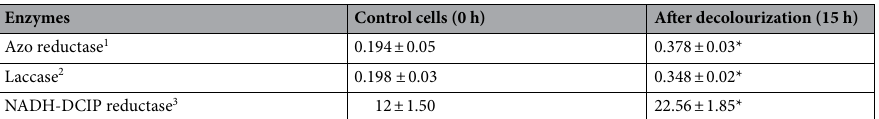
Table 2. Enzyme activity during decolourization of dye Procion Red—H3B by strain P. stutzeri SPM1. Values are mean of three experiments ± standard error of mean (SEM), significantly different from control cells at * P < 0.001 by one-way analysis of variance (ANOVA) with Tukey–Kramer comparison test. 1 μM of methyl red reduced min −1 mL of enzyme −1 mg of protein −1 . 2 μM of ABTS oxidized min −1 mL of enzyme −1 mg of protein −1 . 3 μM of DCIP reduced min −1 mL of enzyme −1 mg of protein −1